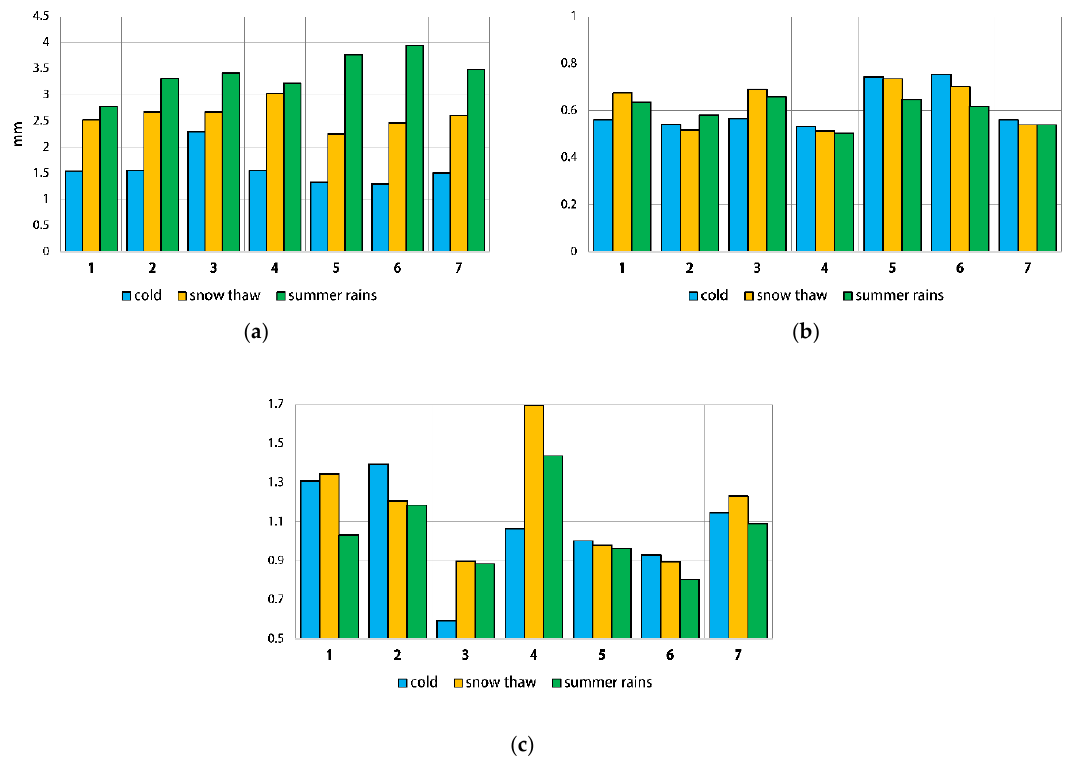
Figure 10. Error statistics (ERA5 versus observational data) for total daily precipitation: root mean square error (RMSE) ( a ), correlation coefficient ( b ), the ratio of the standard deviations (STD) of the ERA5 reanalysis and observed values ( c ) for seven stations and the nearest grid points of ERA5 reanalysis for cold ( blue ), snow thaw ( orange ) and summer rains ( green ) periods.